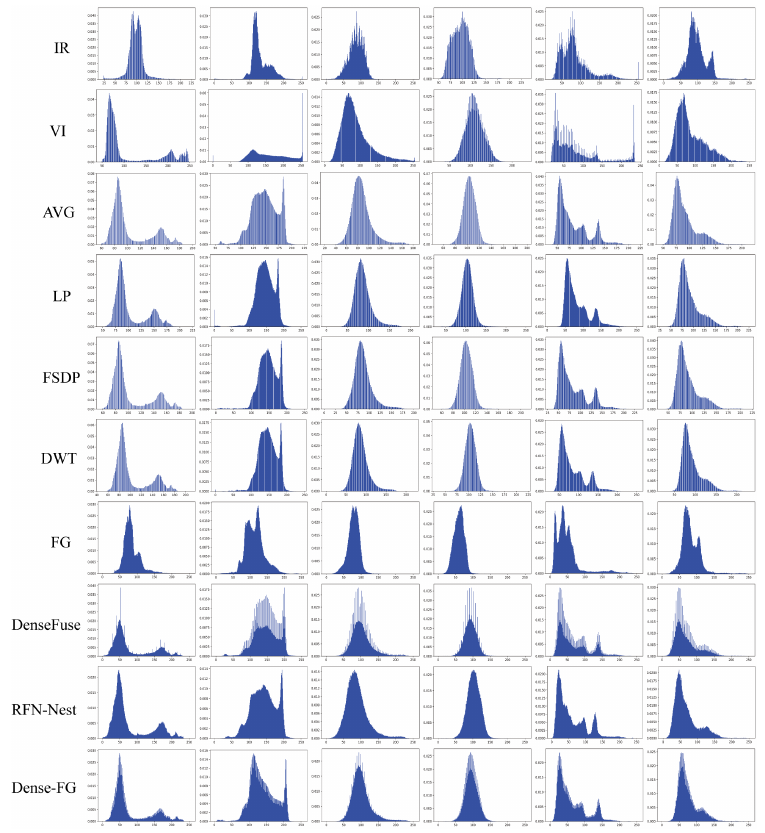
Figure 5. Comparison of histograms of fused results from different